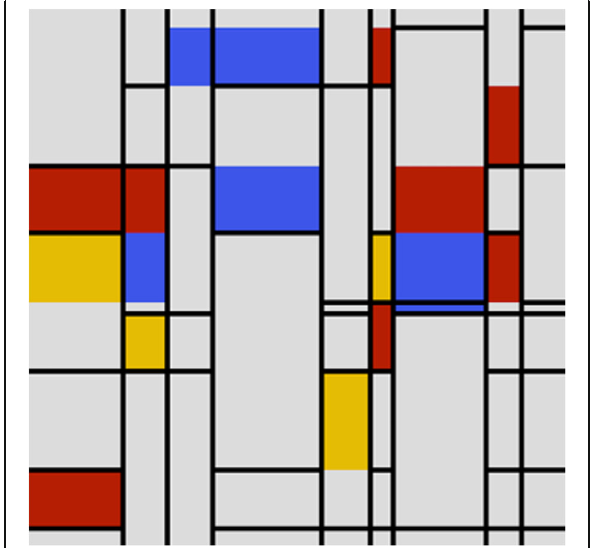
Fig. 15 Kandinsky ’ s “ Composition VIII ” Fig. 16 Computer generated Mondrian ’ s abstract painting